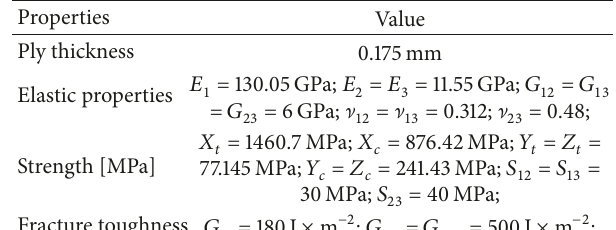
Table 2: Material properties.